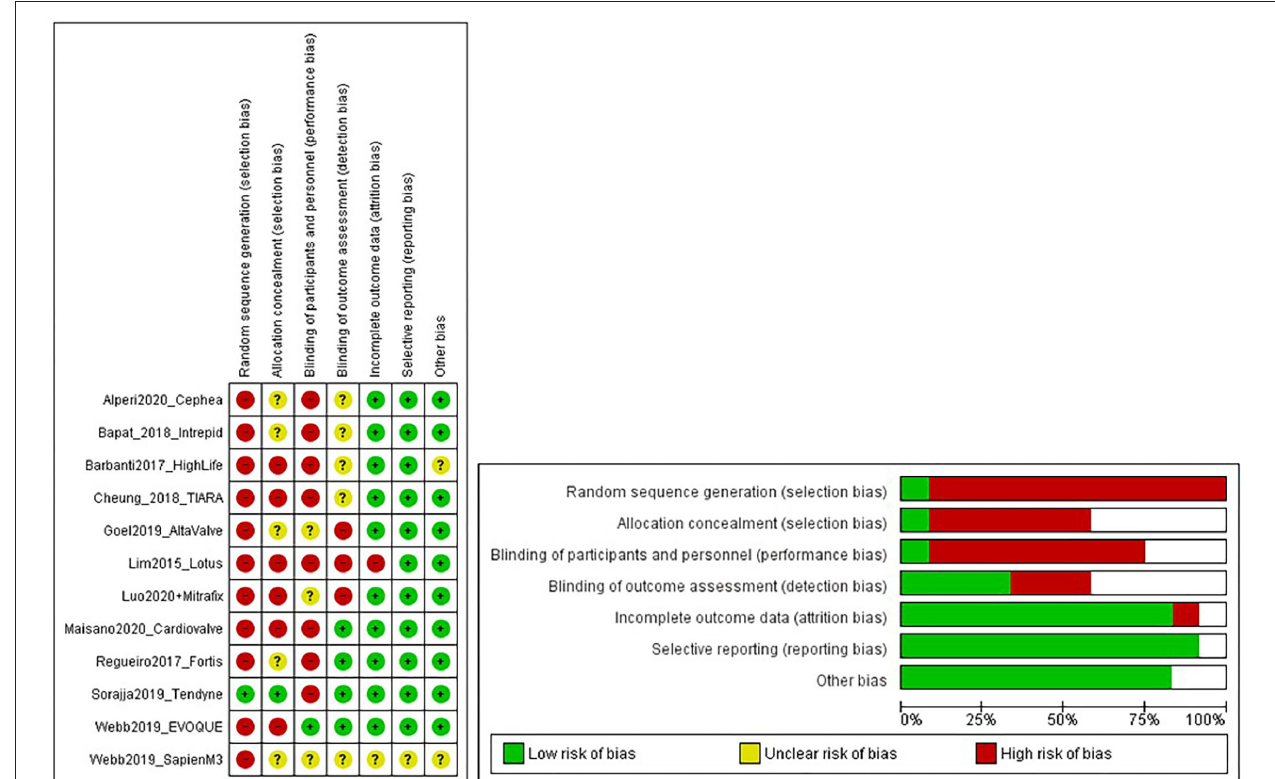
FIGURE 3 | Risk of bias graphs. The figure shows a review of authors’ judgments about each risk of bias item presented as percentages across all included studies. Random sequence generation was made high due to selection bias in First-in-man